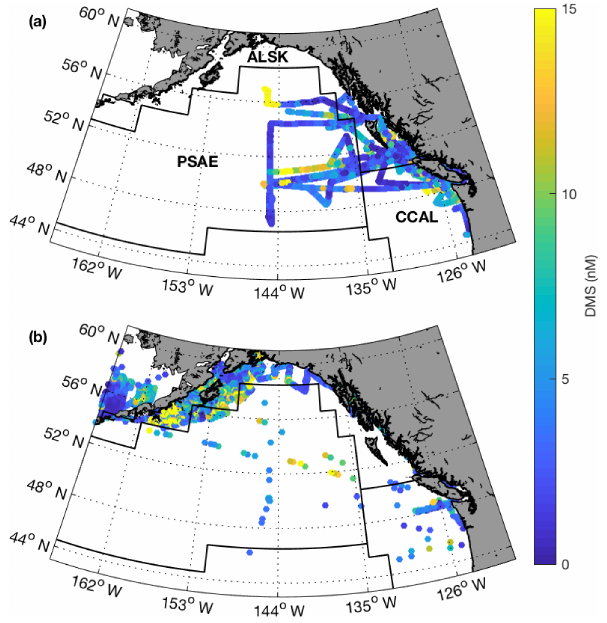
Figure 8. Spatial distribution of summertime DMS measurements from MIMS ( a ; 2004–2017) and the PMEL ( b ; 1984–2004) data set. Black lines represent boundaries of the Longhurst biogeographical provinces, with province names shown in panel (a) .